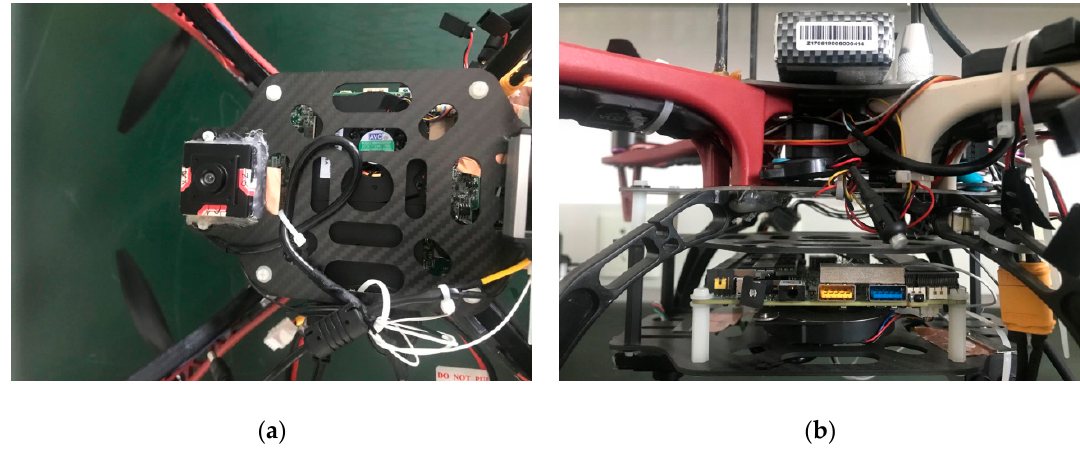
Figure 7. The low-cost camera ( a ) and onboard computer ( b ).